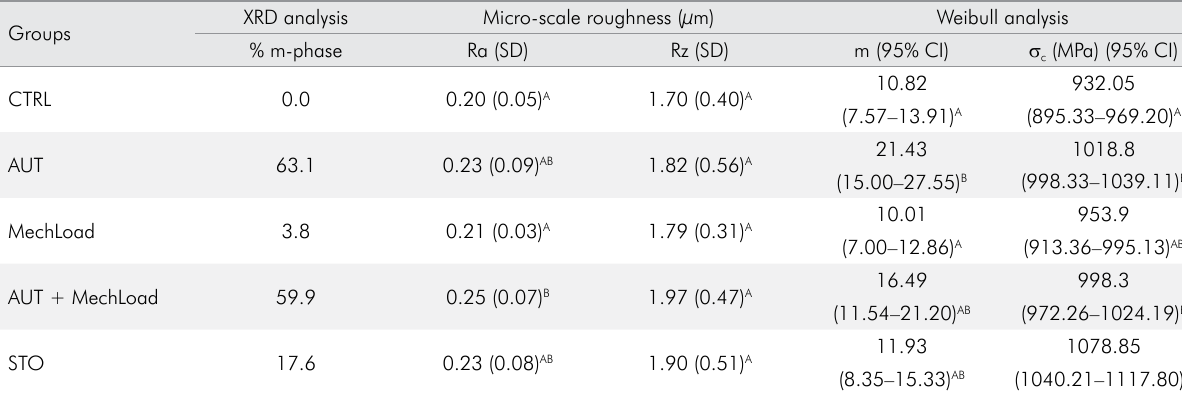
Table. Results (specific means, SD – standard deviations and CI – confidence intervals) obtained from the different analysis. Groups